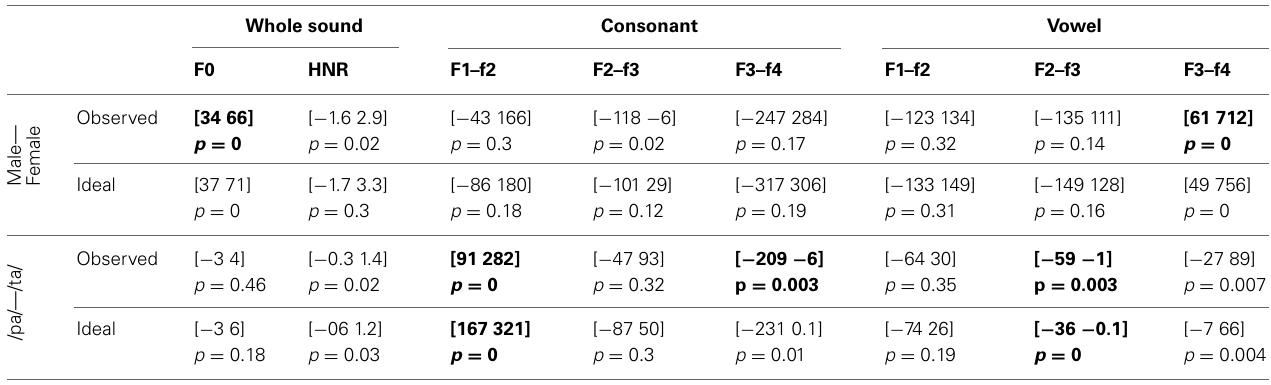
Table 6 | Reverse correlation results for original sounds.